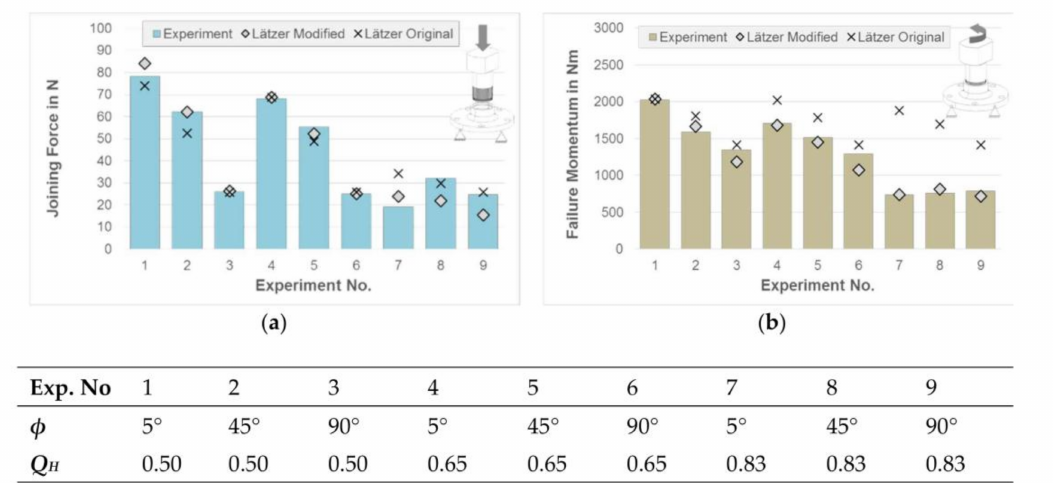
Figure 6. Comparison of joining force ( a ) and torque ( b ) calculations to experiments, D S = 30 mm, α = 103 ◦ , I geo = t · 2 ⁄ 3 , t = 1 mm, µ =